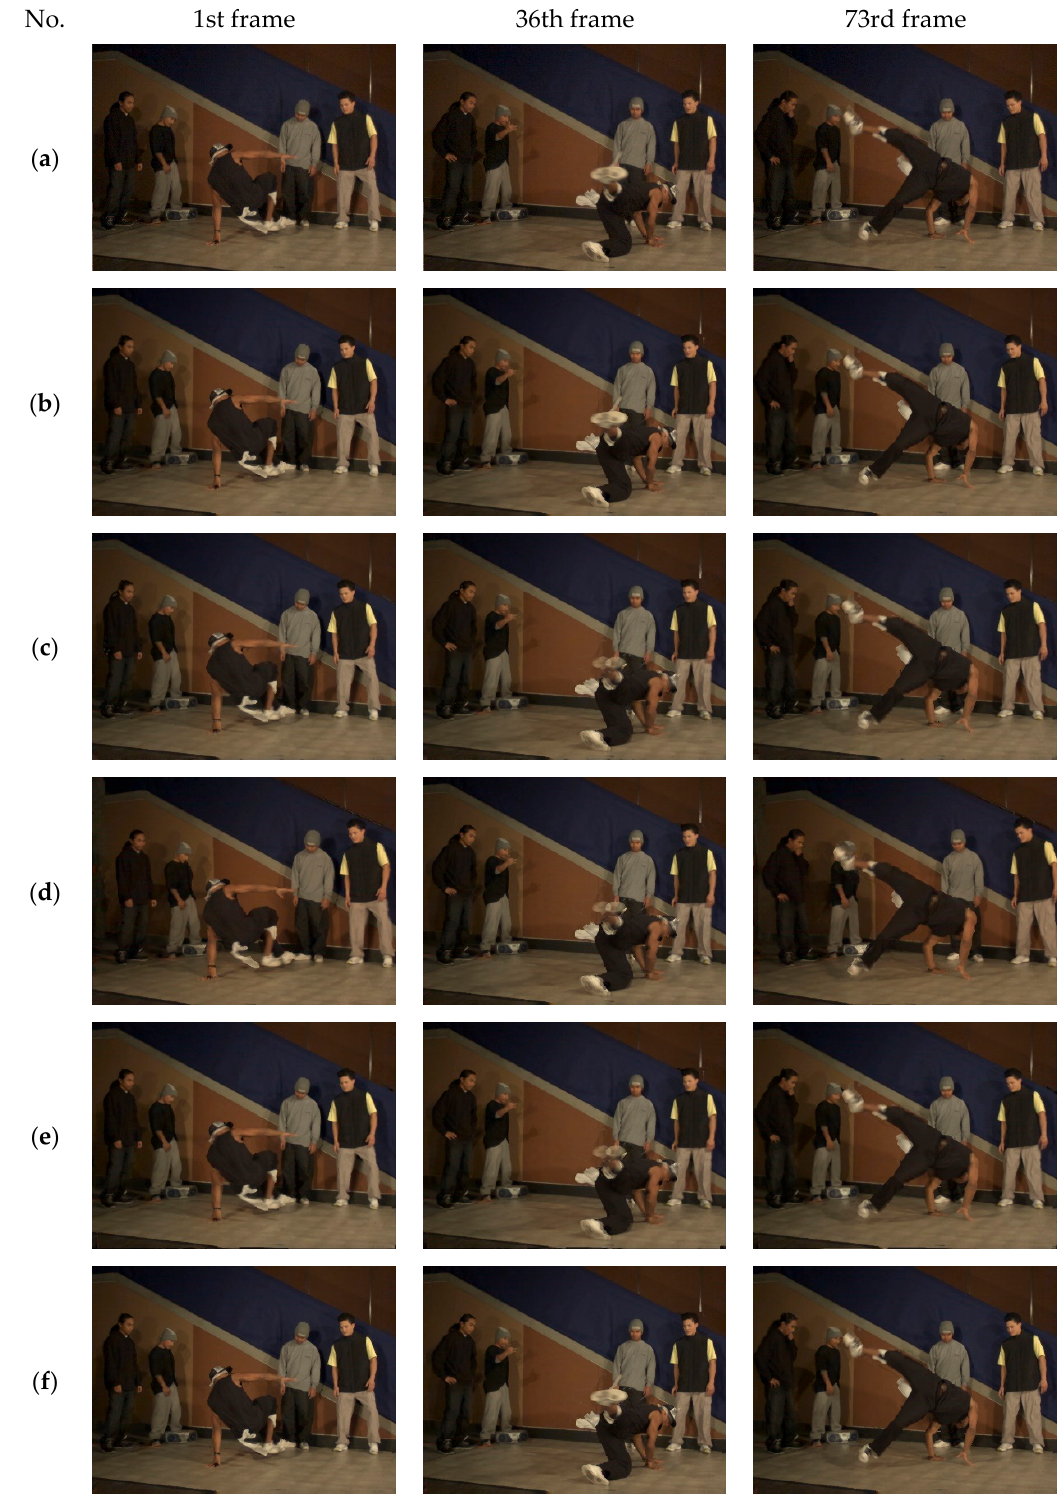
Figure 19. Synthesized virtual view for 1st, 36th, and 73rd frames on Breakdancers dataset. ( a ) Ground truth of Camera 4 of ( b ) Our proposed method. ( c ) Chang et al.’s method [21]. ( d ) Cho et al.’s method [19]. ( e ) Luo and Zhu’s method [26]. ( f ) Oliveira et al.’s method [27].